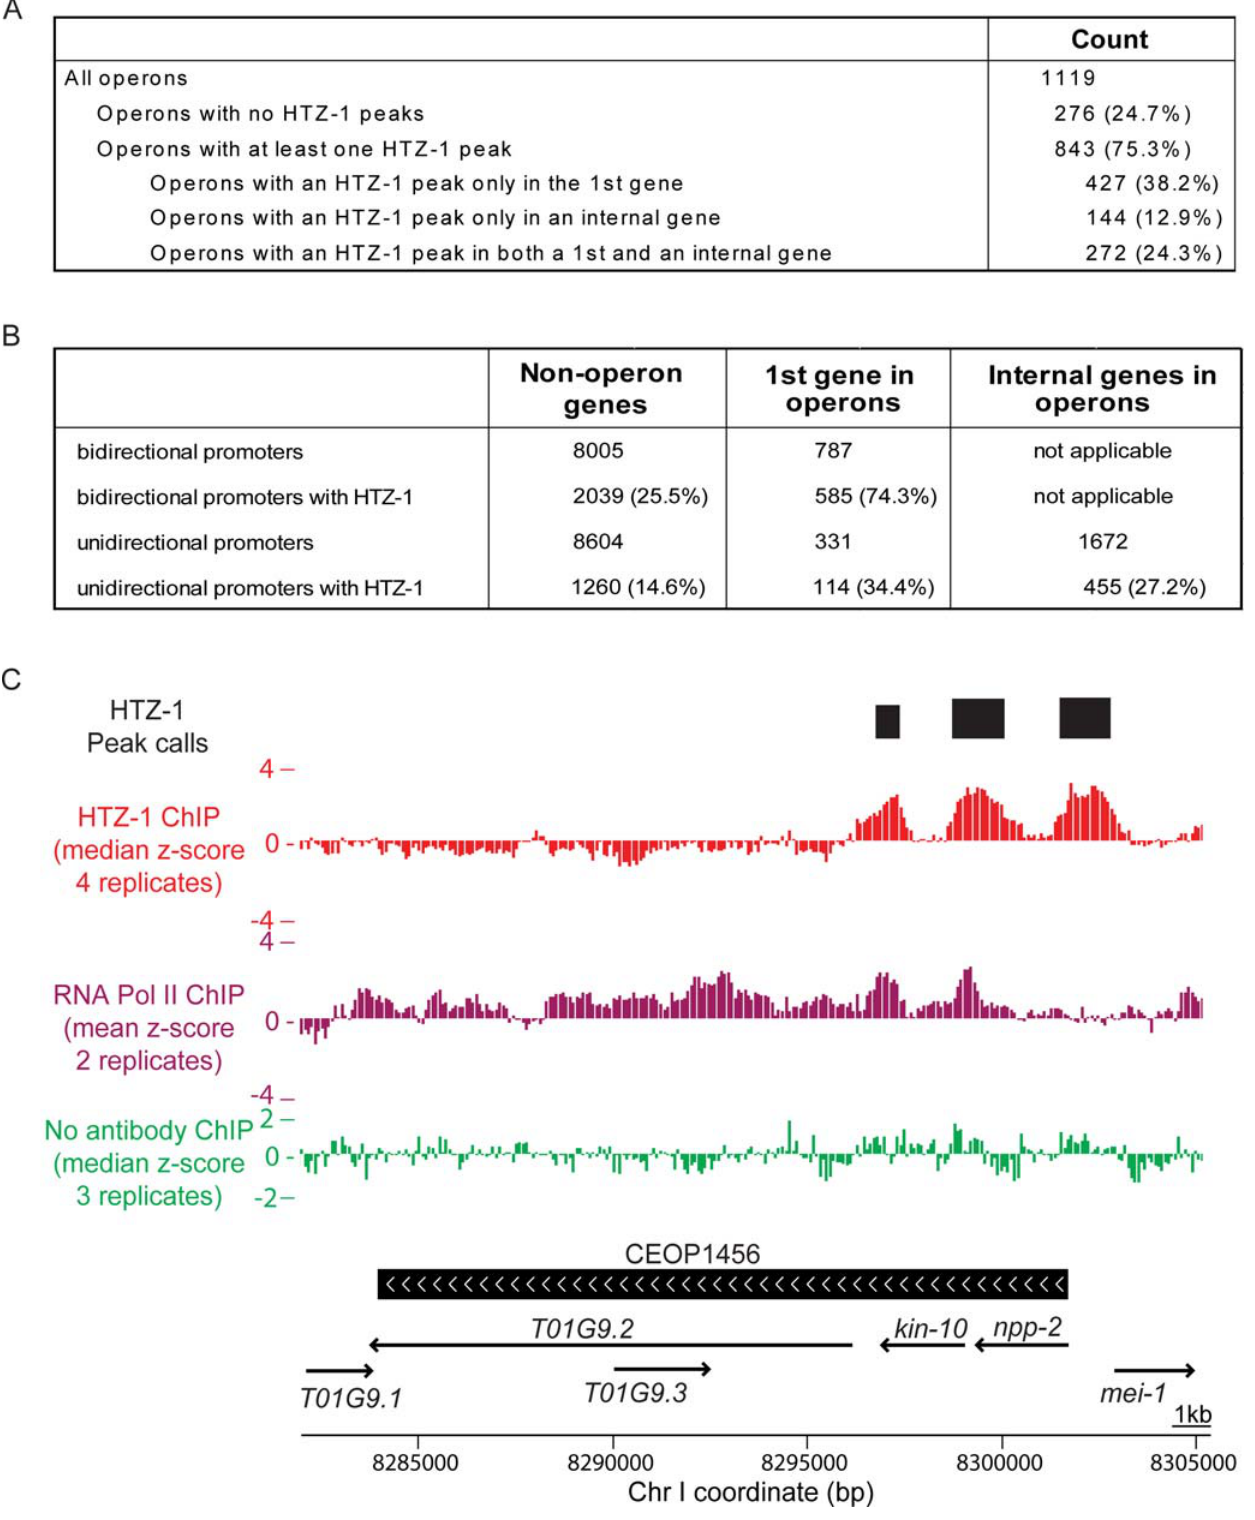
Figure 4. HTZ-1 incorporation predicts internal sites of transcription initiation in operons. (A) Table relating operons and sites of HTZ-1 incorporation. (B) Table relating genes within operons and sites of HTZ-1 incorporation. Bidirectional promoters are defined as those that are upstream of two divergently transcribed genes; unidirectional promoters are upstream of only one gene. (C) A genome browser view of the operon CEOP1456 (black bar with white arrows specifying the direction of transcription). Plotted are: median z-scores for the four HTZ-1 ChIPs (red), mean z- scores of two RNA Pol II replicates (purple), and median of three ‘‘no antibody’’ mock ChIPs (green). Peaks of HTZ-1 binding are denoted on the top track (black bars). Gene annotations indicated below (arrows).